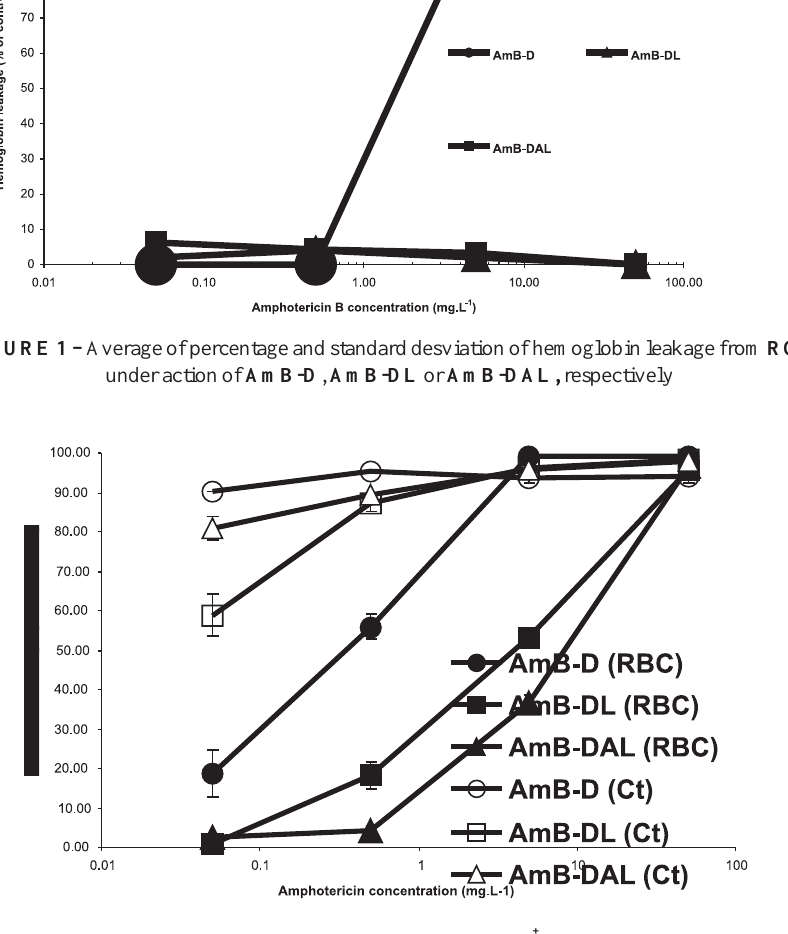
FIGURE 2 – Average of percentage and standard desviation of K + leakage from RCB and Ct under action of AmB-D , AmB-DL or AmB-DAL,